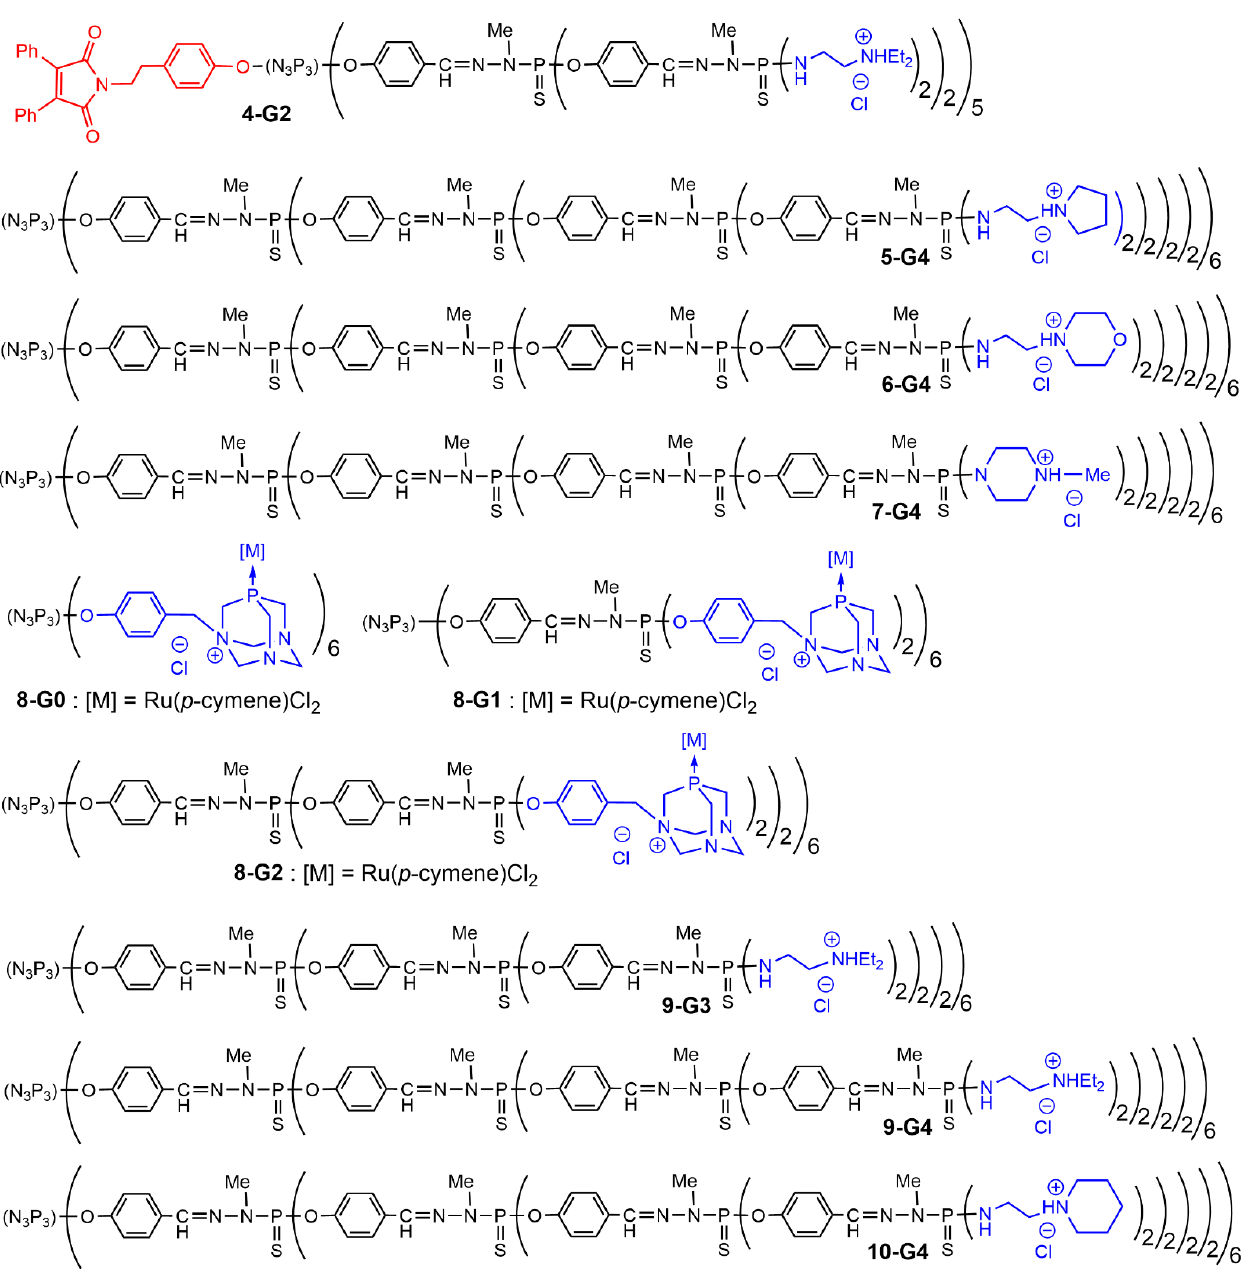
Figure 8. Structure of phosphorus dendrimers forming dendriplexes analyzed by agarose gel elec- trophoresis assays. trophoresis